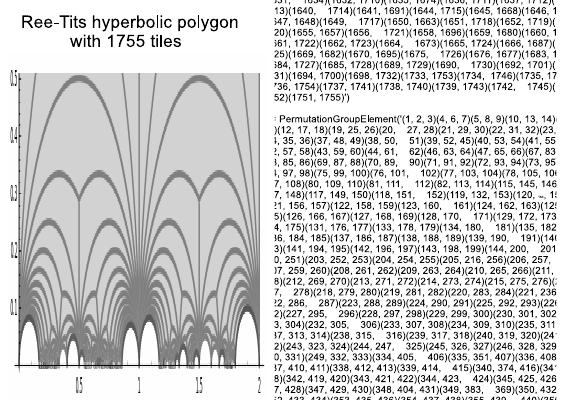
Figure 5. The fundamental domain for the index 1755 permutation group stabilizing the Ree–Tits octagon (details can be found in [27]) and an excerpt of the permutation